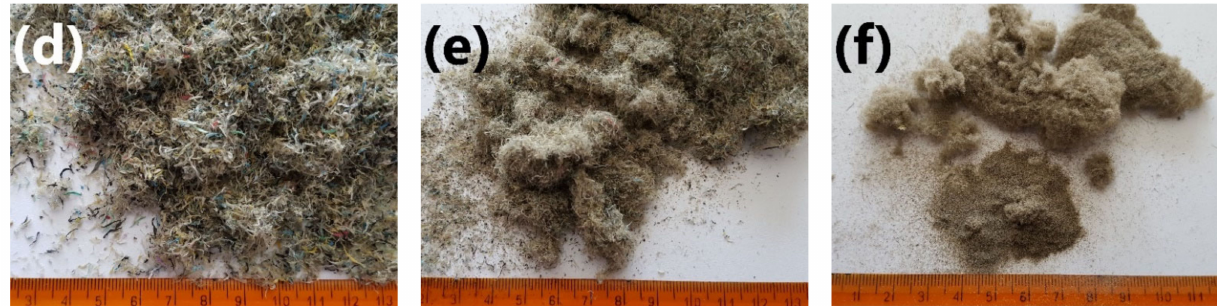
Figure 2. The appearance of M1, M2, M3 wastes and impurities removed during washing and retained on sieves with